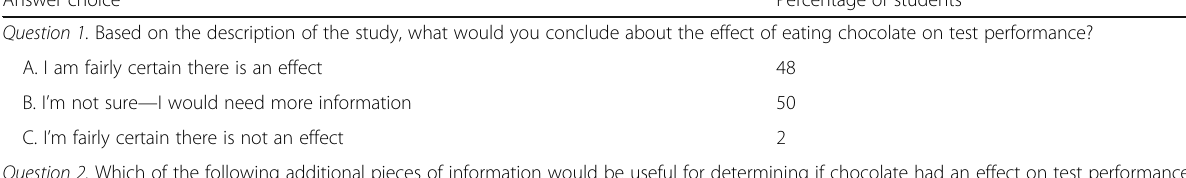
Table 1 Percentage of students selecting each answer choice for the three questions Answer choice Percentage of